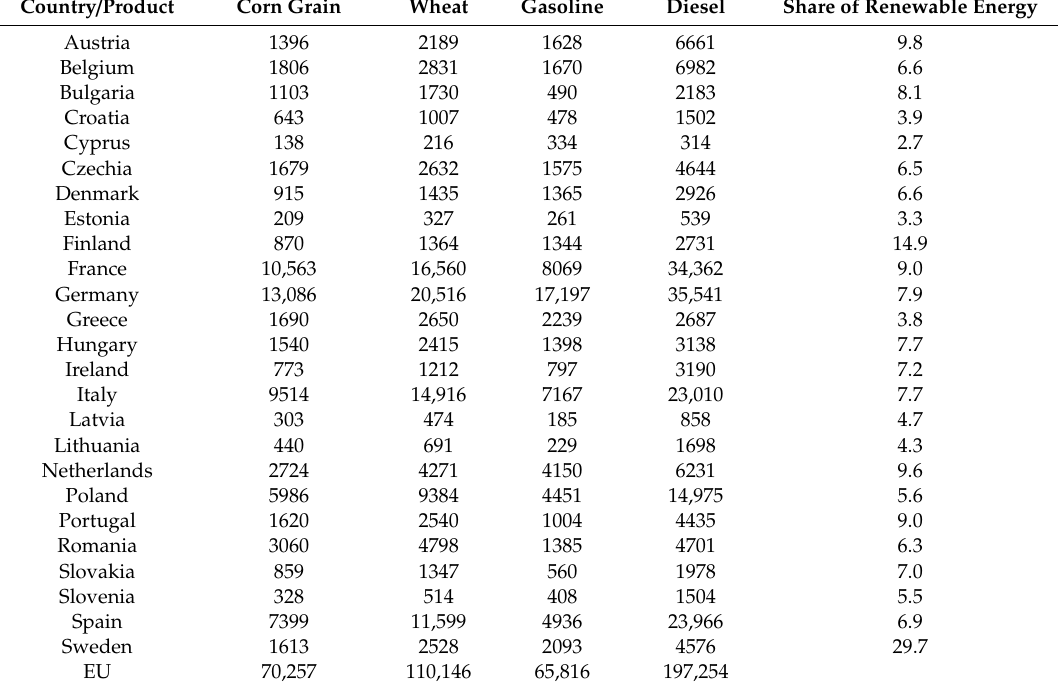
Table 1. Demands for food and transportation fuels (all types, i.e., fossil-based fuels and biofuels) by country (in 1000 t / year) and share of renewables in transport sector in 2018 in percentage. Country / Product